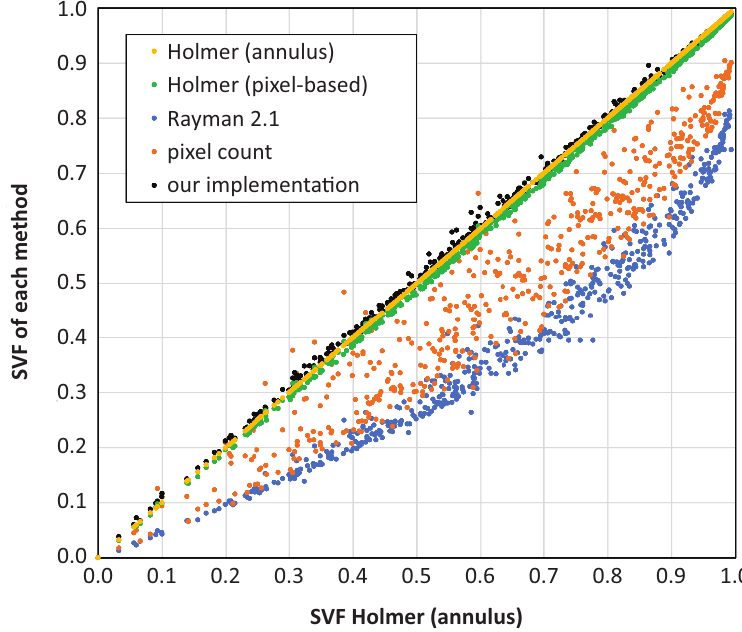
Figure 3. Our Sky View Factor implementation compared to other algorithms. showing that the RayMan model significantly underesti- mates SVFs, especially in the midrange, when Lambert’s law is not considered for the pixel weighting. Lastly, sim- ply calculating the ratio between sky and non-sky pixels yields inaccurate results, since this approach does not ac- count for angular